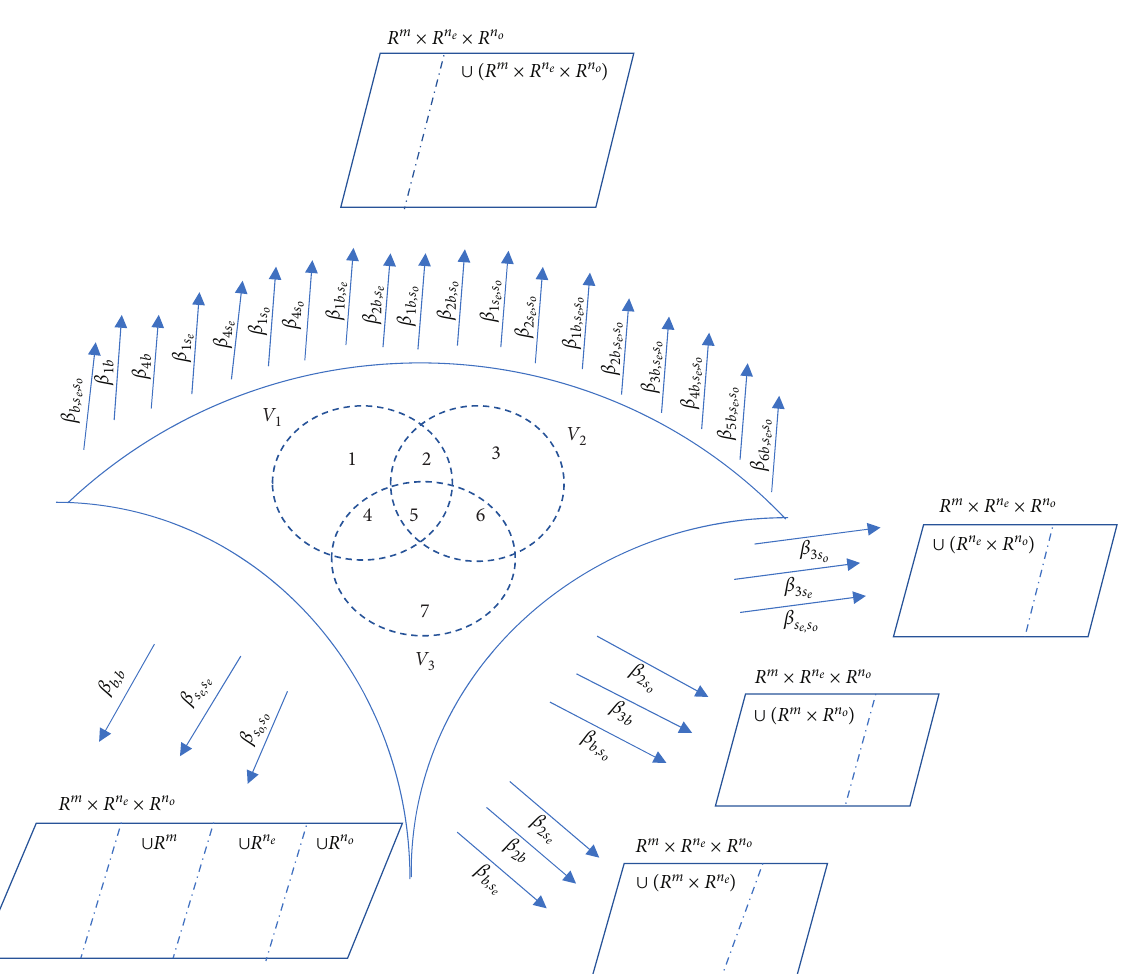
Figure 1: Differentiable structure of a supergraph manifold: definition set and